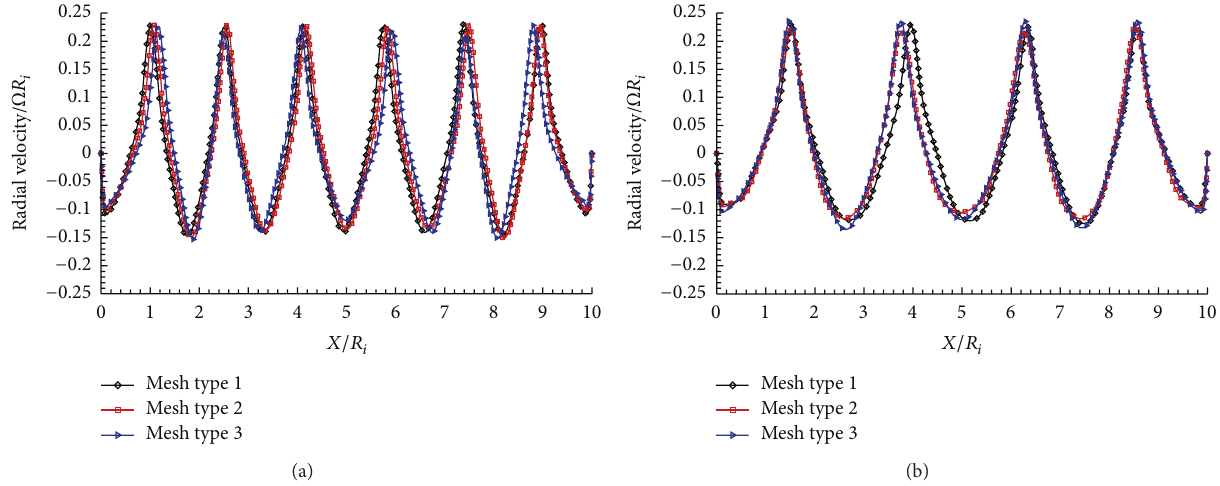
Figure 2: Radial velocity profiles at 𝑟 = 𝑅 𝑖 + 0.5𝑑 for three different levels of computational mesh refinement for test cases (a) Γ = 11.36 and (b) Γ = 7.81